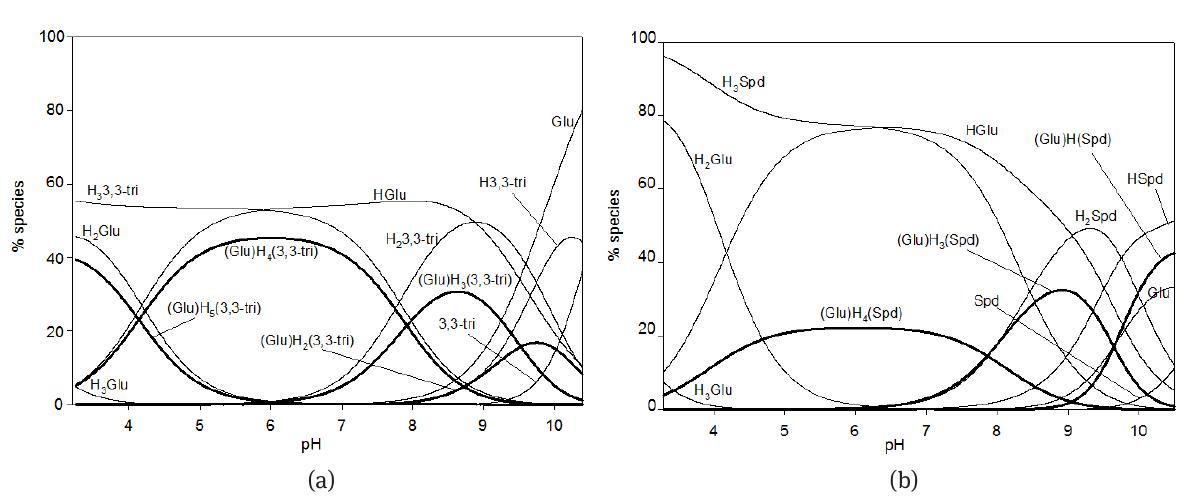
= 1 x 10 -2 M; C = 1 x 10 -2 M, at 20 o C, µ=0.1 mol L -1 (KNO Glu Spd